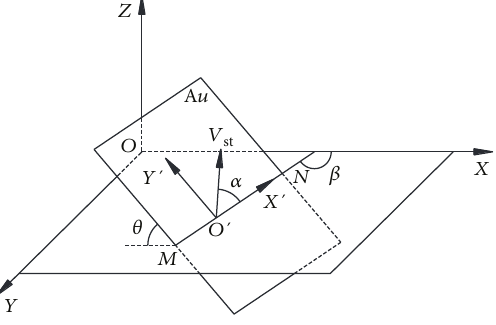
Figure 2: Modular motion-structure design